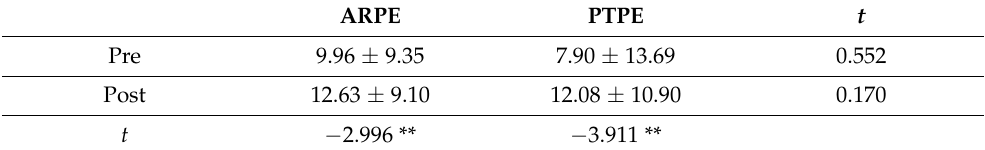
Table 9. Comparison of flexibility within and between groups before and after intervention